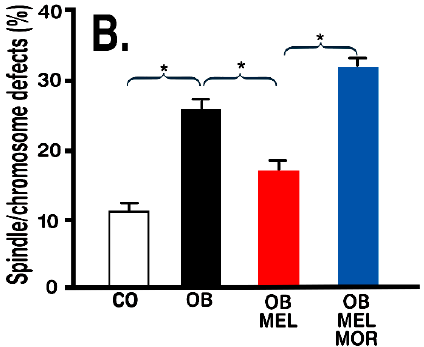
Figure 7. Reactive oxygen species (ROS) levels in oocytes of normal control (NO) and obese (OB) mice ( A ) and mean spindle/chromosomal defects ( B ) of the oocytes (values are means ± SEM). Obesity was associated with an increase in ROS and elevated molecular damage in oocytes. Melatonin (MEL) treatment reduced both parameters. When SIRT3 was silenced (with siRNA) the actions of melatonin were negated. This suggests that the antioxidant action of melatonin in oocytes depends on stimulation (deacetylation) of SIRT3 which enhances the activity of the antioxidant enzyme, superoxide dismutase. Figure drawn from the data of Han et al. [210]. * p > 0.001.